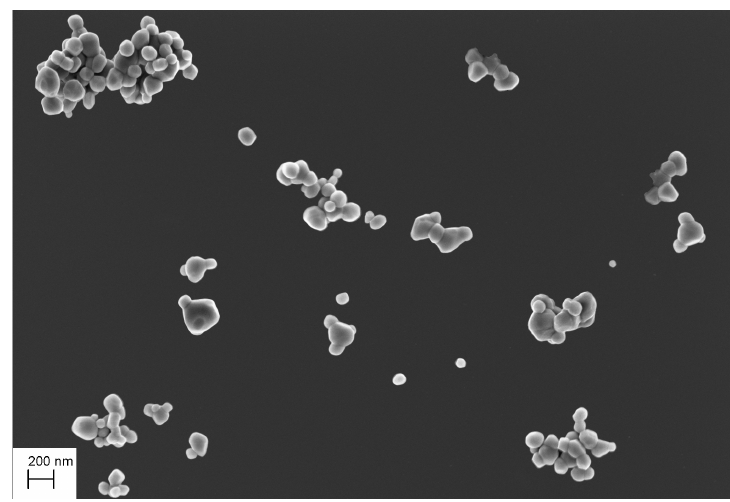
Figure 6. Simulated SEM image of TiO 2